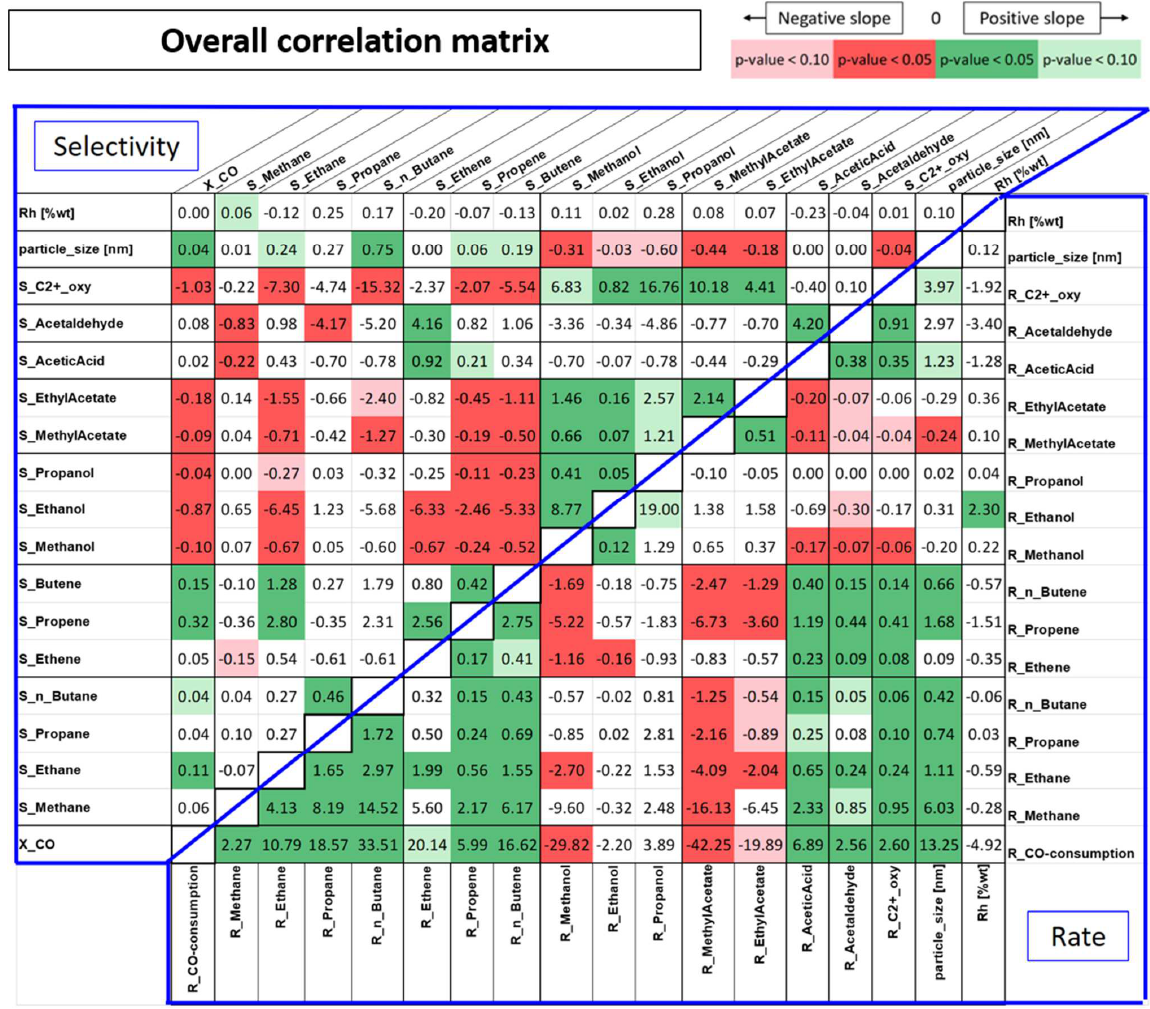
Figure 9. Overall correlation matrix between rate and selectivity descriptors of main products and particle size in Exp 1. The values in each cell depict the slope of the best-fit line between the descriptor pair. The cells are colored based on the p -value obtained for regression; the sign of the slope is such that red and green colors denote a negative and positive slope, respectively; light and dark colors denote the significance level for the p -value obtained.